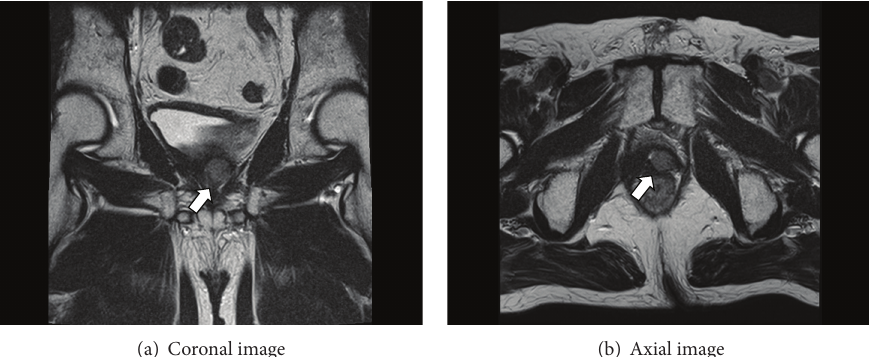
Figure 1: MRI images of local recurrence. T2 weighted image demonstrated a low-intensity area in the left side of prostatic bed.